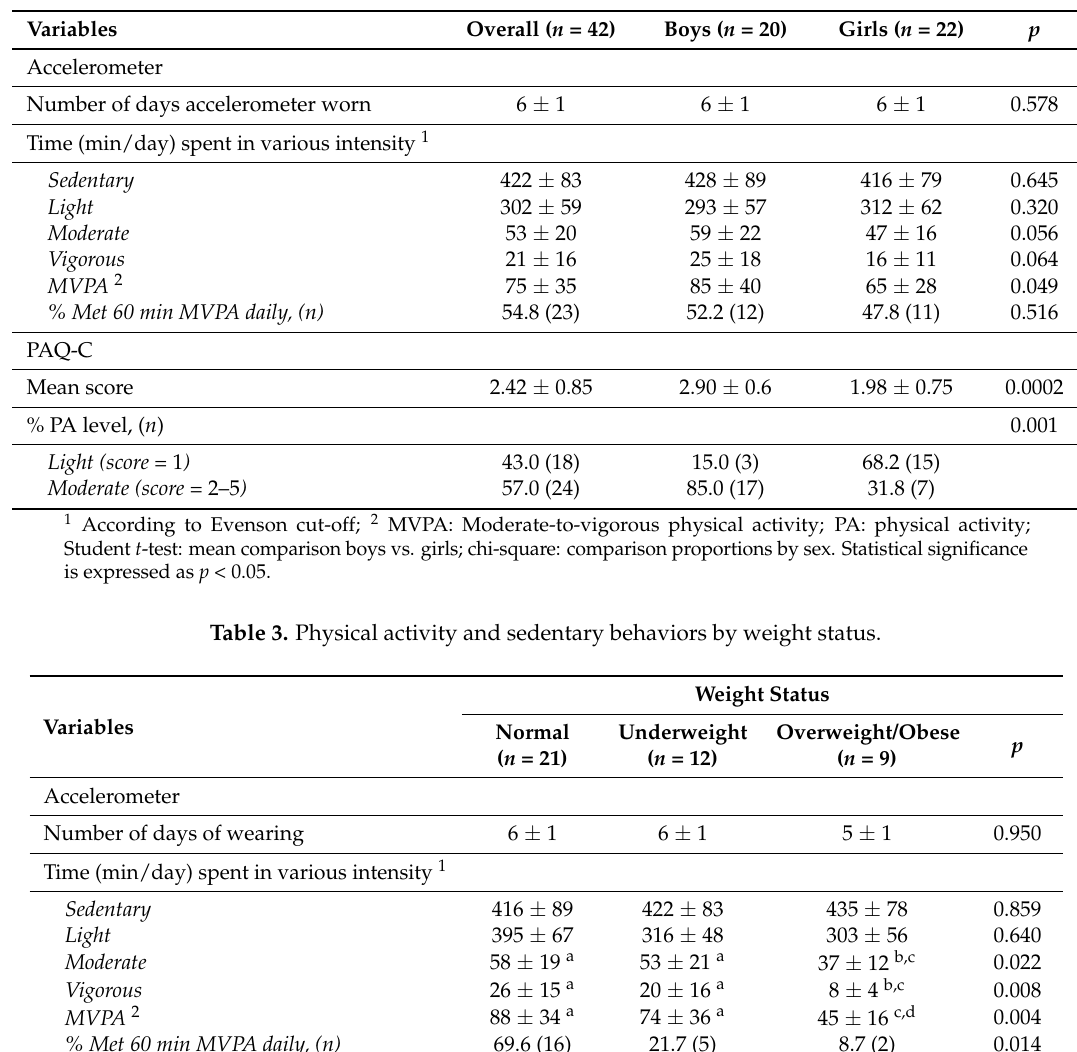
Table 2. Physical activity and sedentary behaviors by sex.